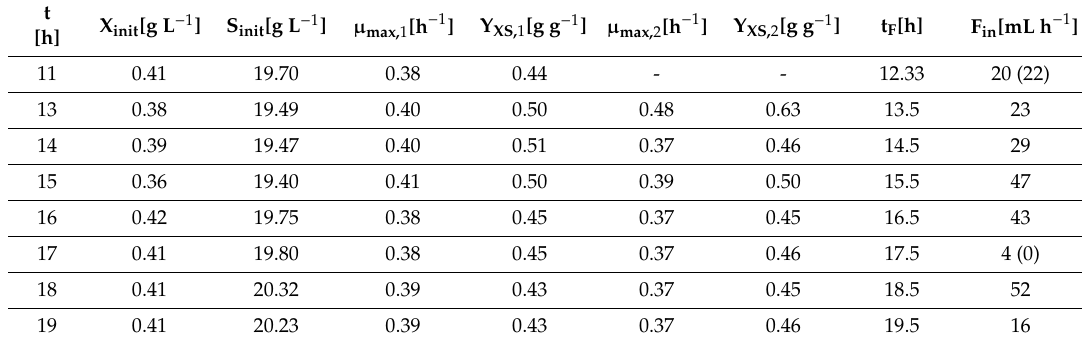
Table A14. Estimated initial concentrations for biomass X init and glucose S init and estimated model parameters for the maximum specific growth rate biomass µ max and yield coe ffi cient biomass / substrate Y XS (for batch phase index 1 and for fed-batch phase index 2) at process timepoint t. Calculated optimized feed rate F in for timepoint t F .